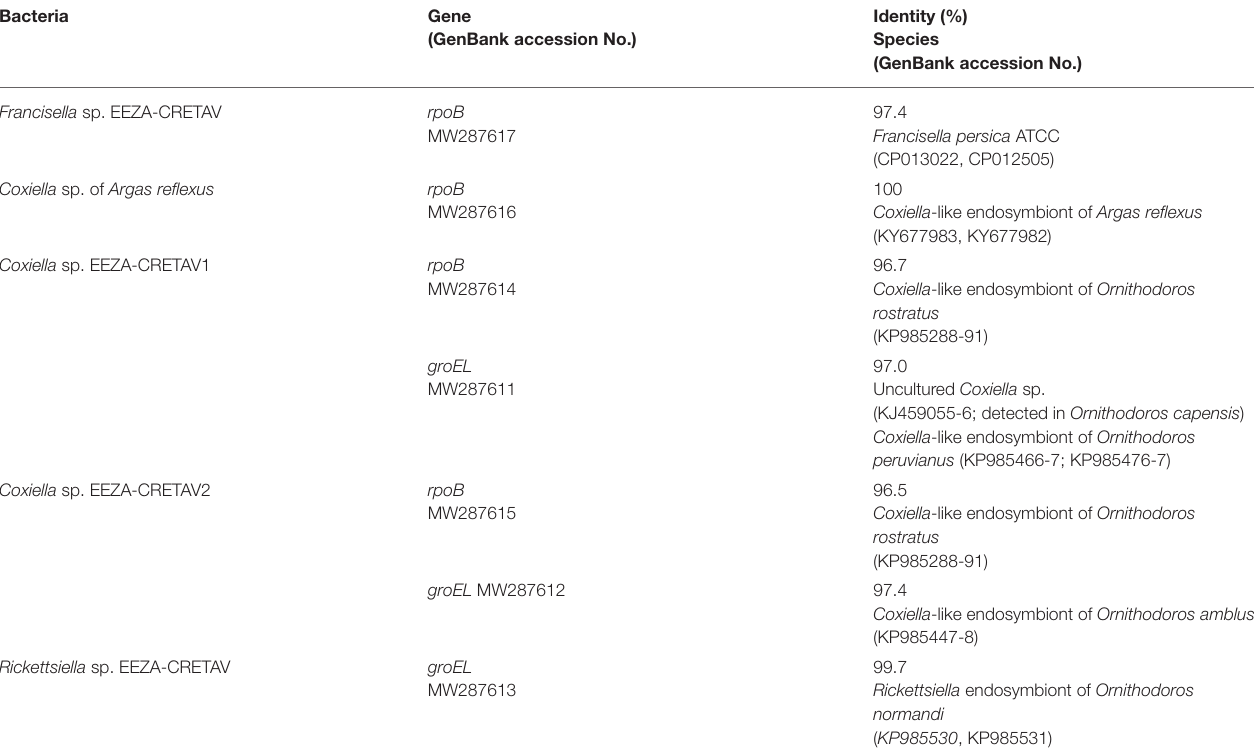
TABLE 5 | Highest identities reached between fragment genes of Francisella , Coxiella, and Rickettsiella spp. detected in the present study and published sequences. Bacteria Gene (GenBank accession